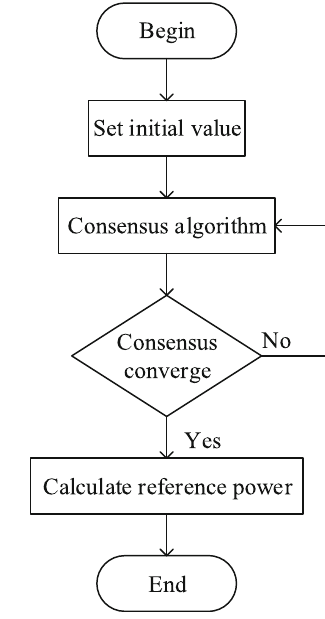
Fig. 4 Flow chart of power